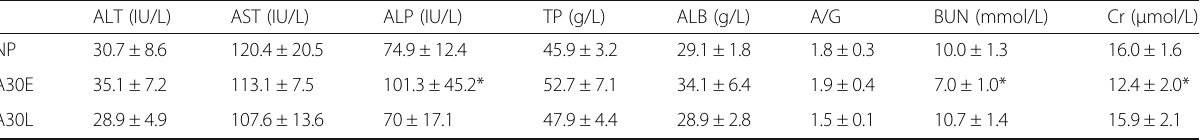
Table 2 Biochemical analysis of blood serum of pregnant mice ALT (IU/L) AST (IU/L) ALP